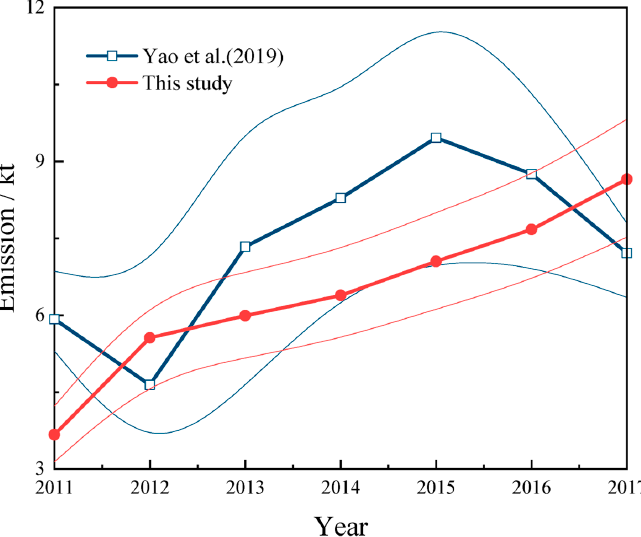
Figure 2. Comparison of HFC-134a emissions from top-down studies in the North China Plain. Yao et al. [29].